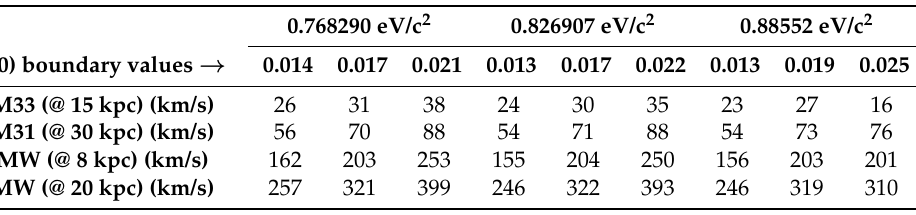
Table 9. Local Group CNO-induced approximate galactic rotational speeds for the degenerate neutrino masses determined from the weak lensing data fits.